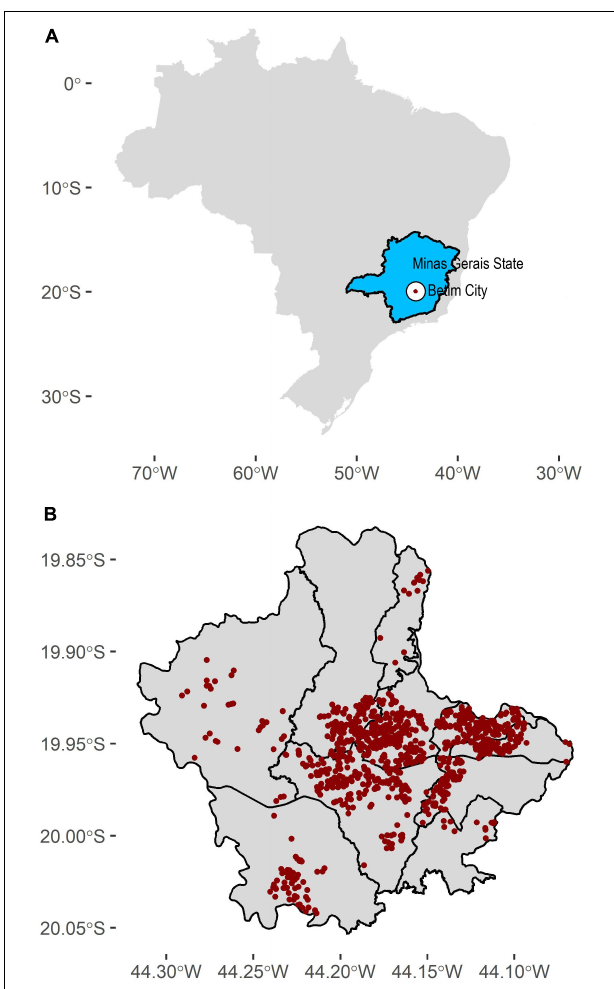
FIGURE 1 | Sampling strategy throughout Betim city. (A) Betim’s geographical location (white area) in the Minas Gerais State (blue area). (B) Sampling locations for each survey ( n = 1080). We sampled all populated areas in the town. Areas without points indicate non-populated areas.